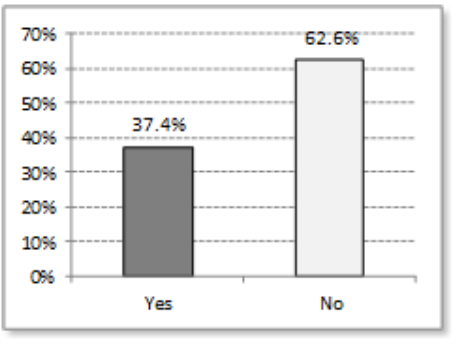
Figure 15. Percentage of deaf and hard of hearing participants who have dropped out of an on-line course at some time (relative data). Valid answers: